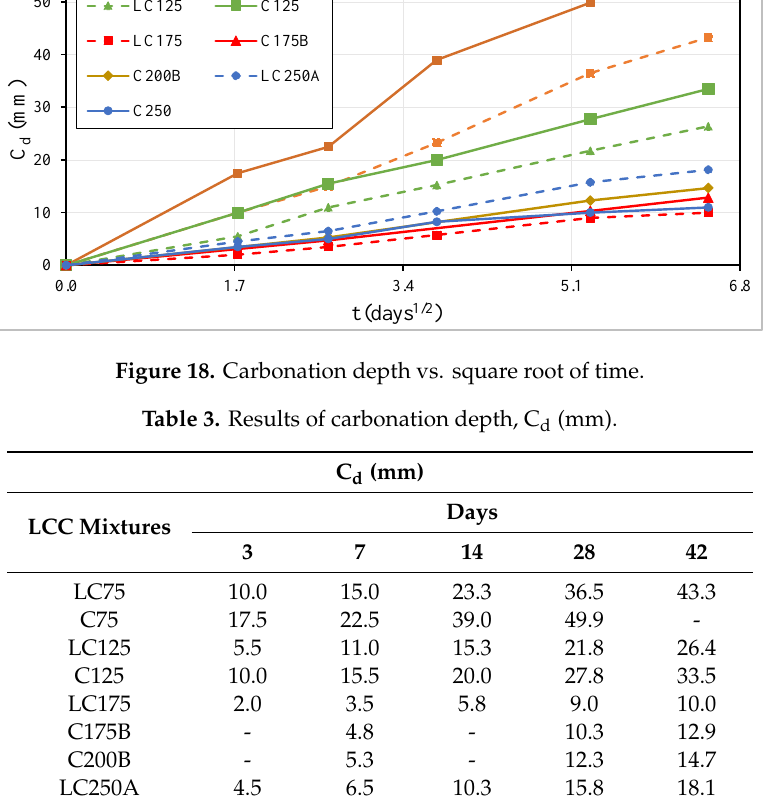
Figure 18. Carbonation depth vs. square root of time.